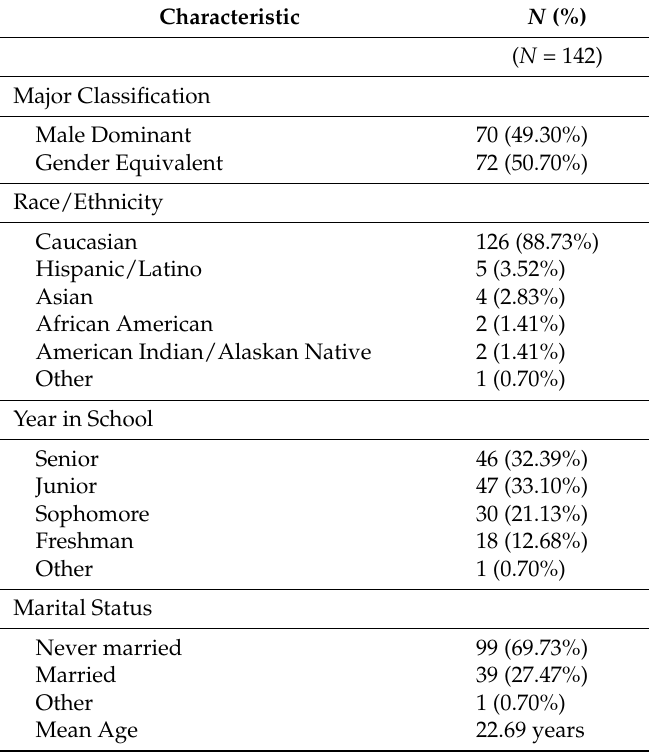
Table 1. Demographic characteristics of